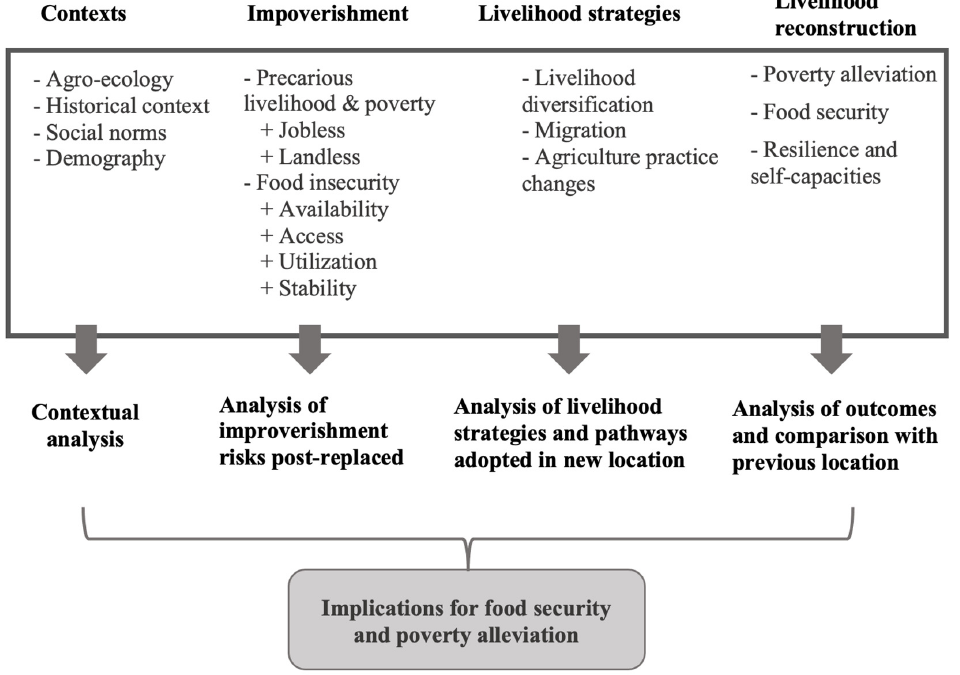
Figure 1. Conceptual framework of the study (adapted from Cernea 2002, 1997; McDowell 2002; FAO 2006).